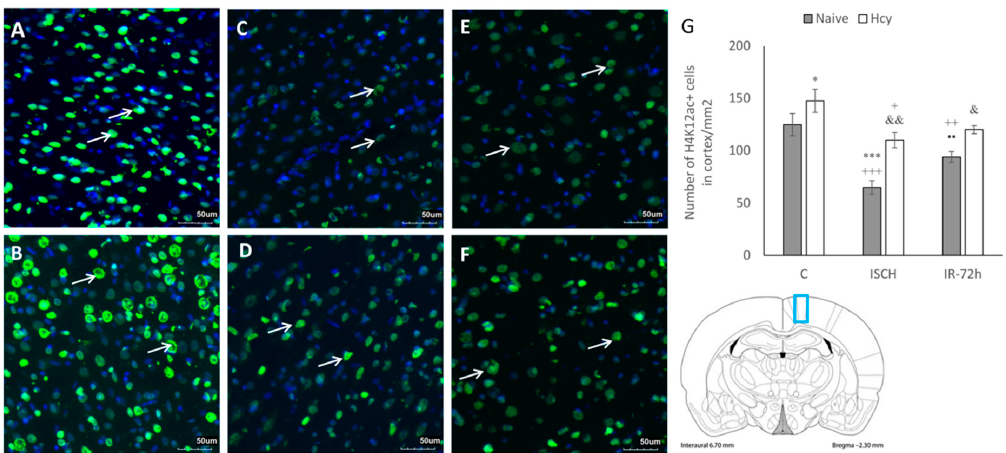
Figure 3. Fluorescence micrographs and statistical evaluation of H4K12ac positive (+) neurons in the M1 area (blue rectangle on the schematic coronal section) of rat brain cortex. Micrographs of naive control ( A ), Hcy-C ( B ), naive ISCH ( C ), Hcy-ISCH ( D ), naive IR-72h ( E ) and Hcy-IR-72h ( F ). Arrows indicate H4K12ac+ neuronal nuclei (green) in the M1 area of rat brain. Nuclei are co-stained with DAPI (blue). Bar = 50 µm, n = 5/group. ( G ) Number of H4K12ac+ nuclei in the M1 area in naive control, Hcy-C, naive ISCH, Hcy-ISCH, naive IR-72h and Hcy-IR-72h. Results are presented as mean ± SEM, n = 5/group. * p < 0.05 and *** p < 0.001 versus the control value; + p < 0.05, ++ p < 0.01 and +++ p < 0.001 versus the control with Hcy; •• p < 0.01 versus the naive ISCH group; & p < 0.05 and && p < 0.01 versus the corresponding reperfusion period.